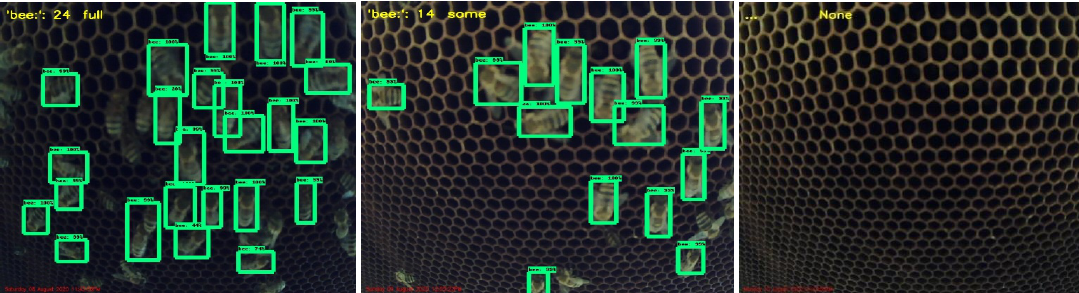
Figure A1. Bee detection with the NVIDIA Jetson Nano using the Faster-RCNN algorithm, Inception v2 model, for Classes 0, 2, and 3.